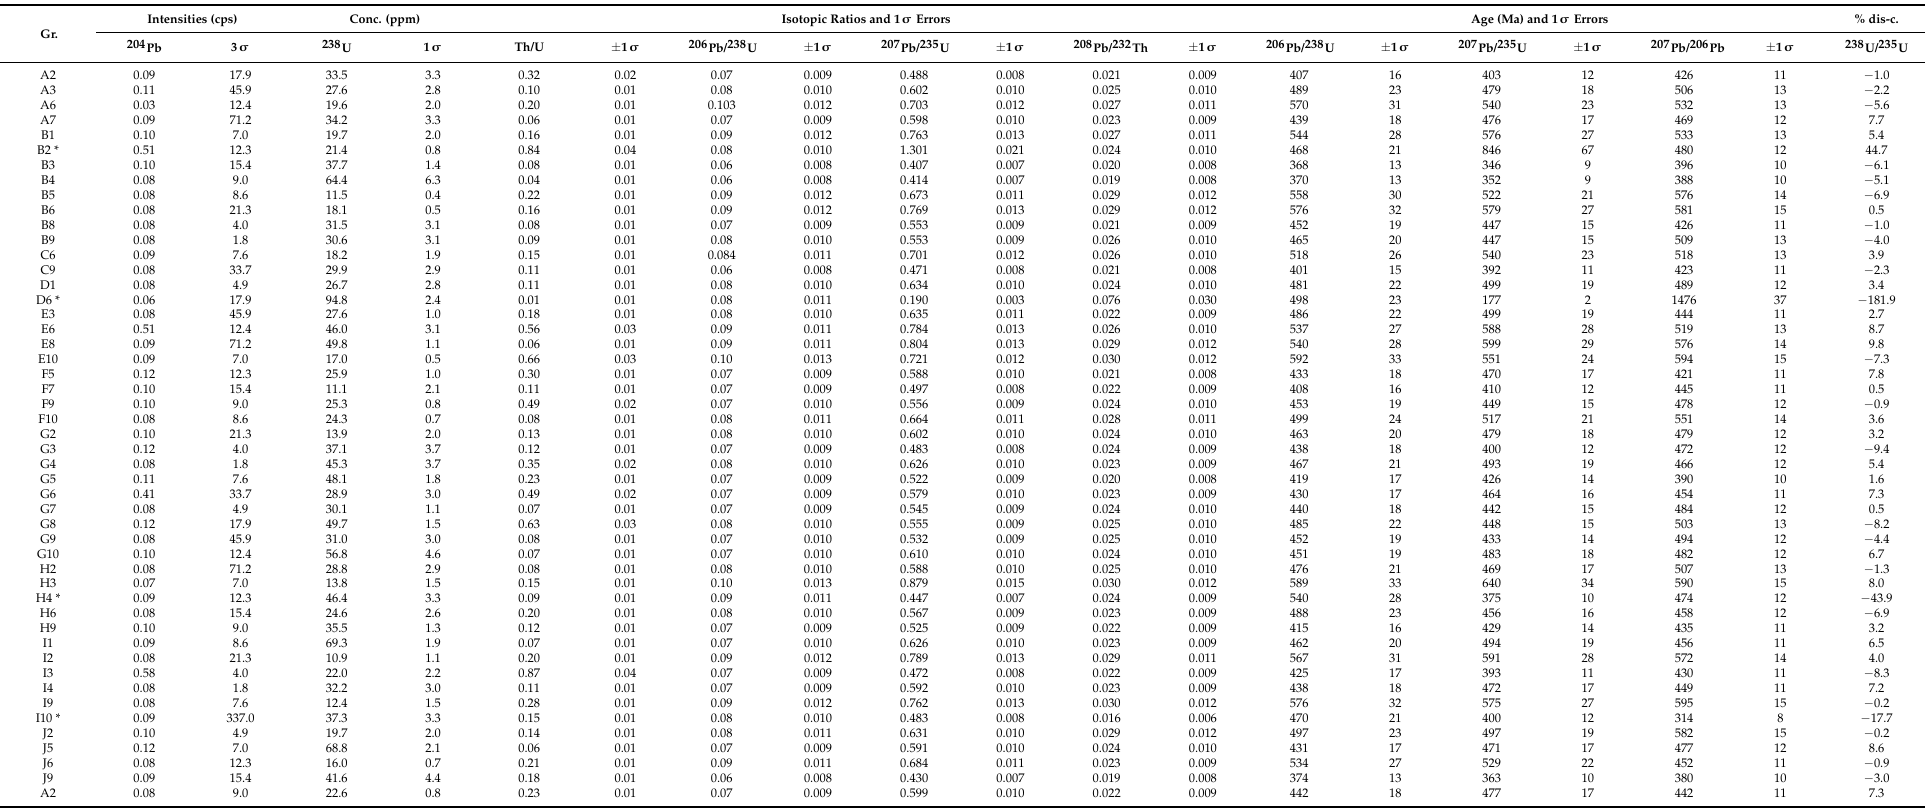
Table 3. Apatite U-Th-Pb Data for the studied